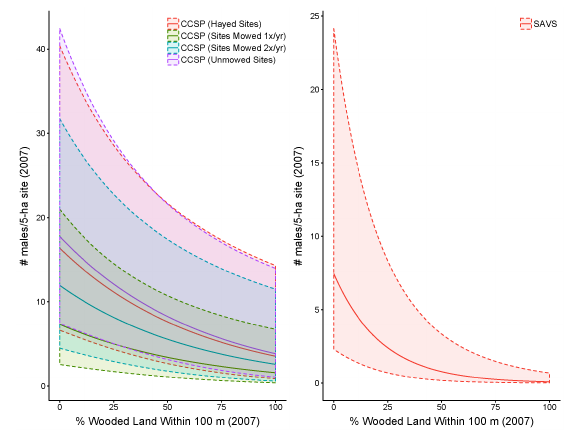
Fig. 2. Predicted relationship for Clay-colored Sparrow (CCSP) and Savannah Sparrow (SAVS) densities based on the percentage of land within 100 m of study sites consisting of wooded lands (trees or shrubs) in 2007. The relationships are as determined by the best-ranked hierarchical distance-sampling model for each species in 2007.